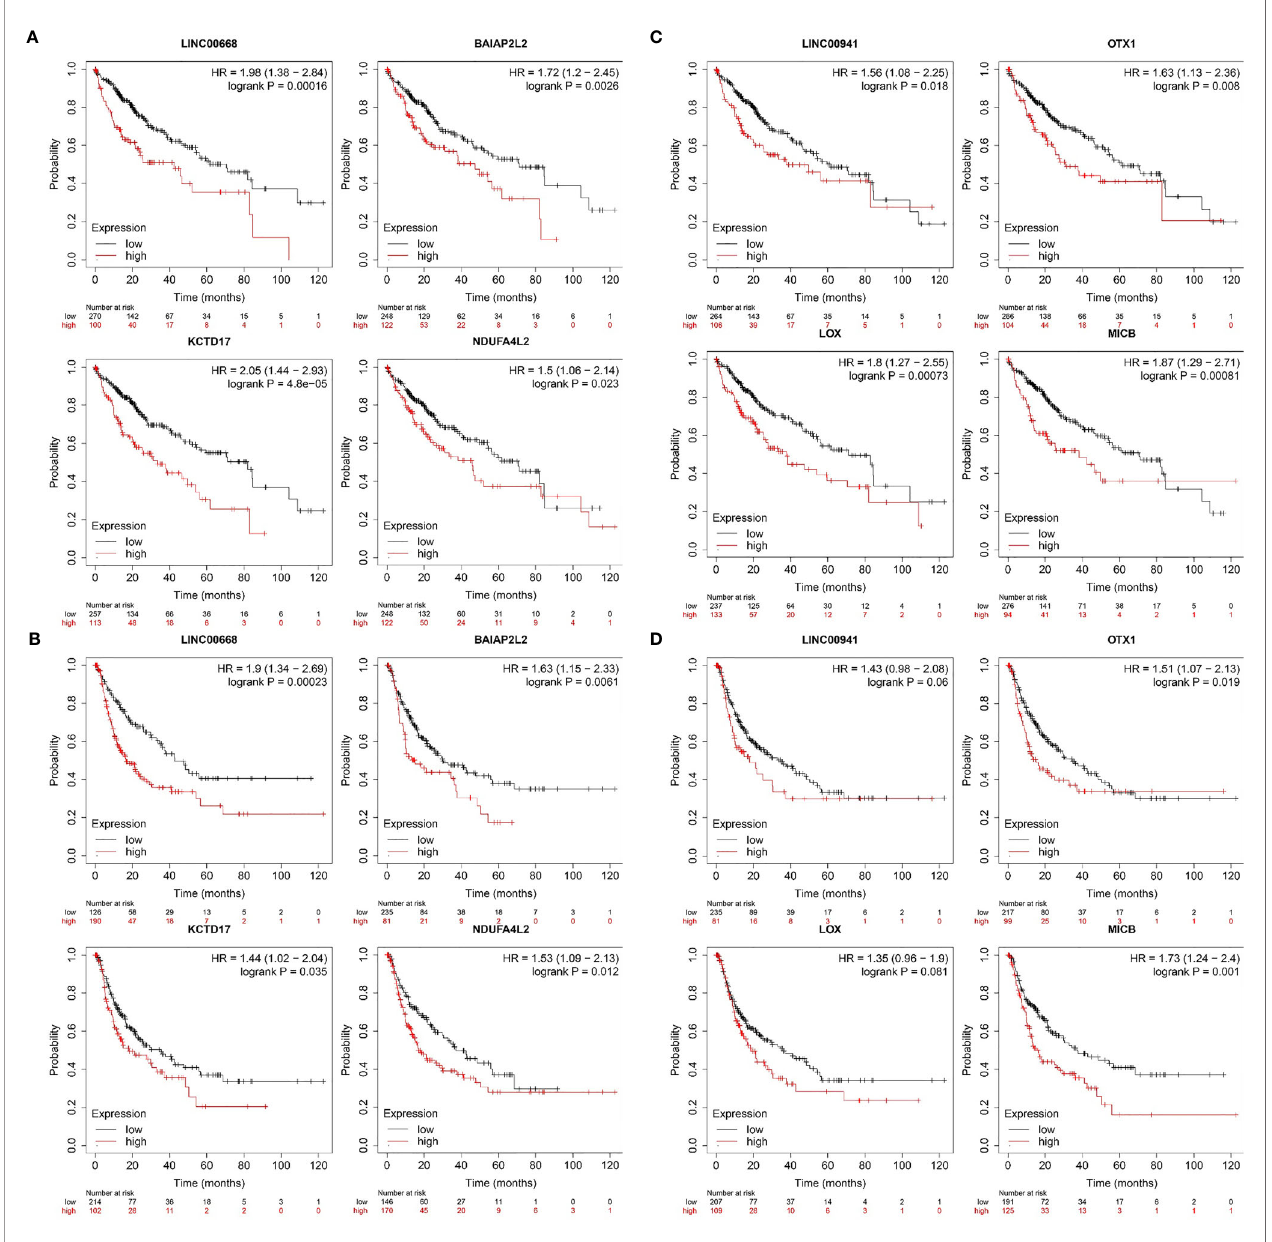
FIGURE 9 | Survival analysis of hub genes in the key modules using the Kaplan-Meier Plotte (A) Kaplan – Meier analysis of OS based on the expression level of LINC00668 and its co-expression mRNA in 370 HCC patients from TCGA. (B) Kaplan – Meier analysis of RFS based on the expression level of LINC00668 and its co- expression mRNA in 316 HCC patients from TCGA. (C) Kaplan – Meier analysis of OS based on the expression level of LINC00941 and its co-expression mRNA in 370 HCC patients from TCGA. (D) Kaplan – Meier analysis of RFS based on the expression level of LINC00941 and its co-expression mRNA in 316 HCC patients from